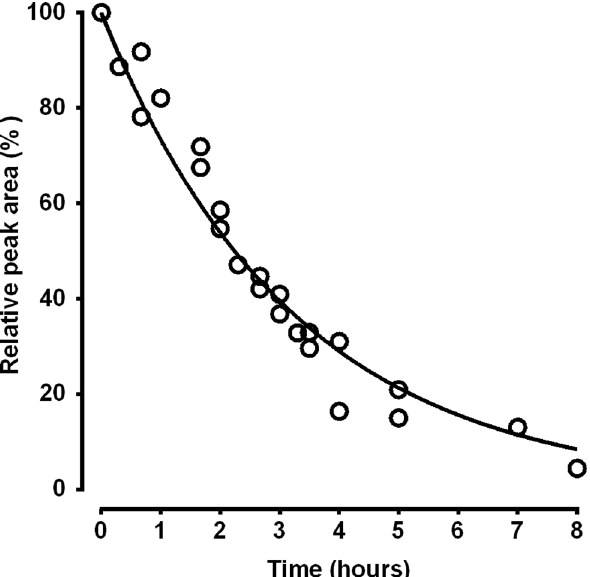
Fig 7. Kinetic analysis of oxaliplatin degradation in membrane vesicle incubation buffer containing glutathione. Open symbols represent individual values of oxaliplatin chromatographic peak areas pooled from two independent experiments. The line represents a nonlinear one phase exponential decay regression fit (r 2 = 0.964) to the data giving an oxaliplatin degradation half-life of 2.24 hours (95%CI, 2.08 to 2.43